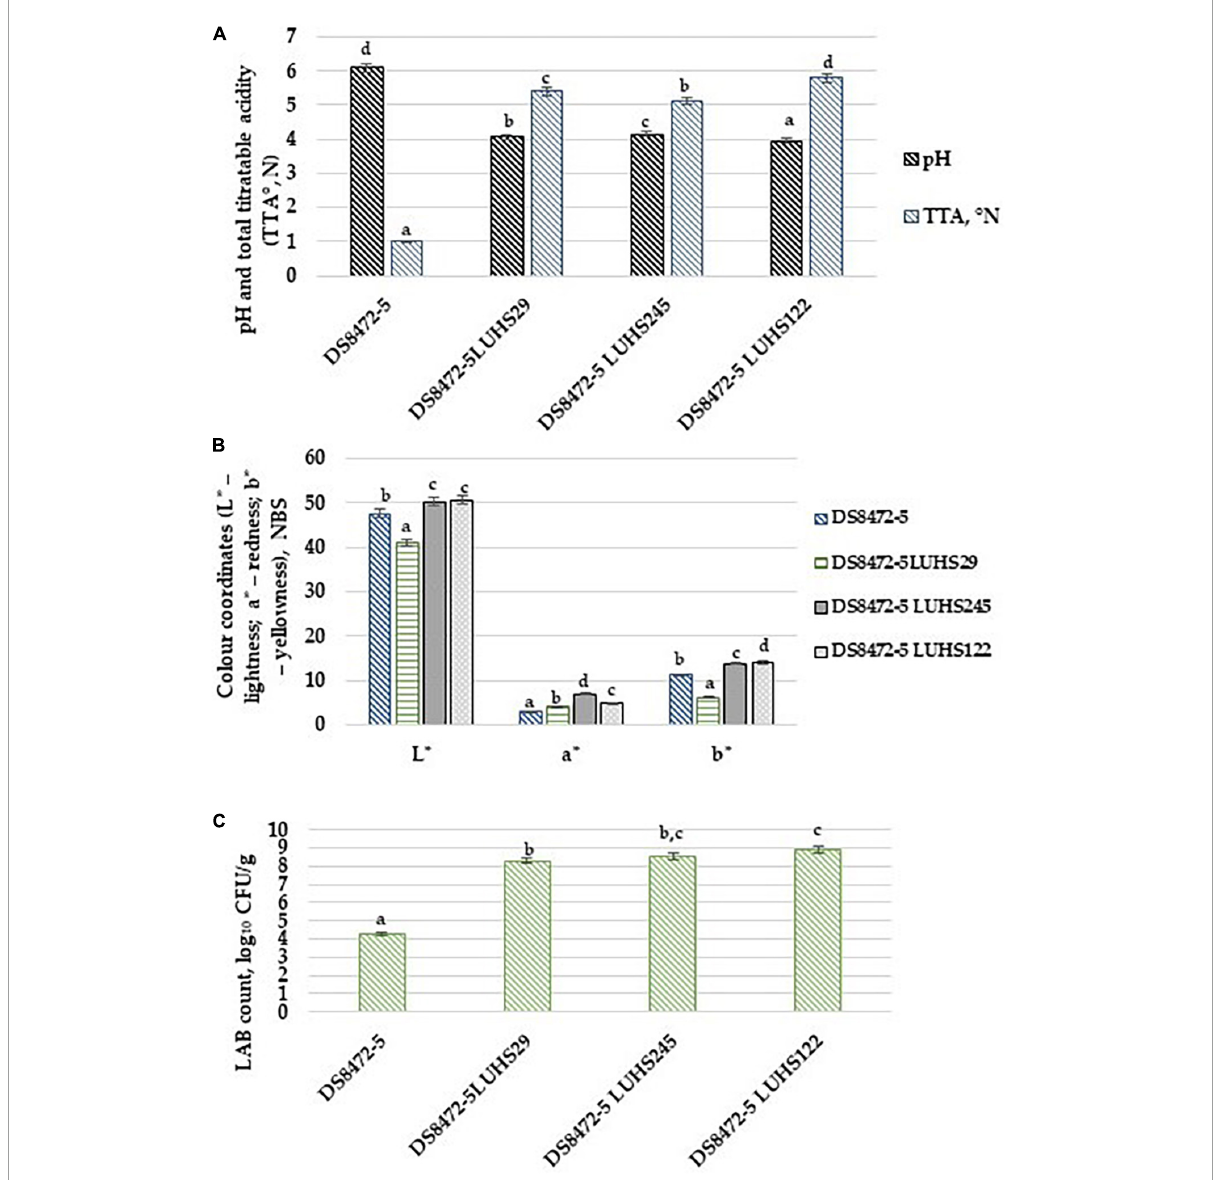
FIGURE2 (A) Acidity, (B) chromaticity and (C) microbiological characteristics of wheat cereal wholemeal (WCW) (DS8472-5) samples. LAB, lactic acid bacteria; CFU, colony forming units; L*, lightness; a*, redness; b*, yellowness. LUHS29, treated with Pediococcus acidilactici LUHS29 ; LUHS245, treated with Liquorilactobacillus uvarum LUHS245 ; LUHS122, treated with Lactiplantibacillus plantarum LUHS122. Physicochemical parameters presented as the mean ( n = 3) ± standard error (SE). The data on lactic acid bacterial viable counts presented as the mean of ( n = 5) ± SE. a − d Means with different letters in column are significantly different ( p ≤